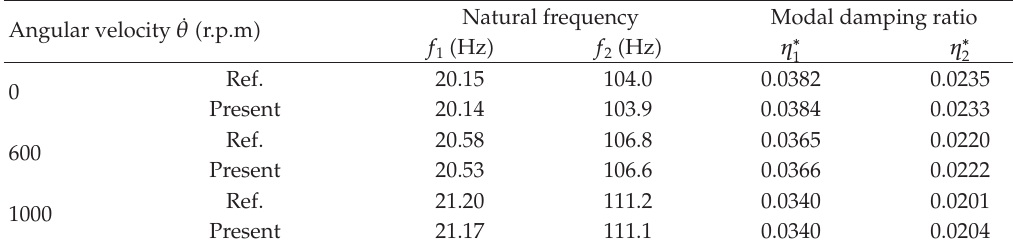
Table 2: Comparison of a rotating beam for natural frequencies and modal damping ratio obtained herein with those of (cid:5) 26 (cid:6) (cid:2) L (cid:8) 300mm, b (cid:8) 12 . 7mm, h 1 (cid:8) 0 . 762mm, h 3 (cid:8) 2 . 286mm, h 2 (cid:8) 0 . 25mm, G ∗ 0 . 38i (cid:3)(cid:3) .